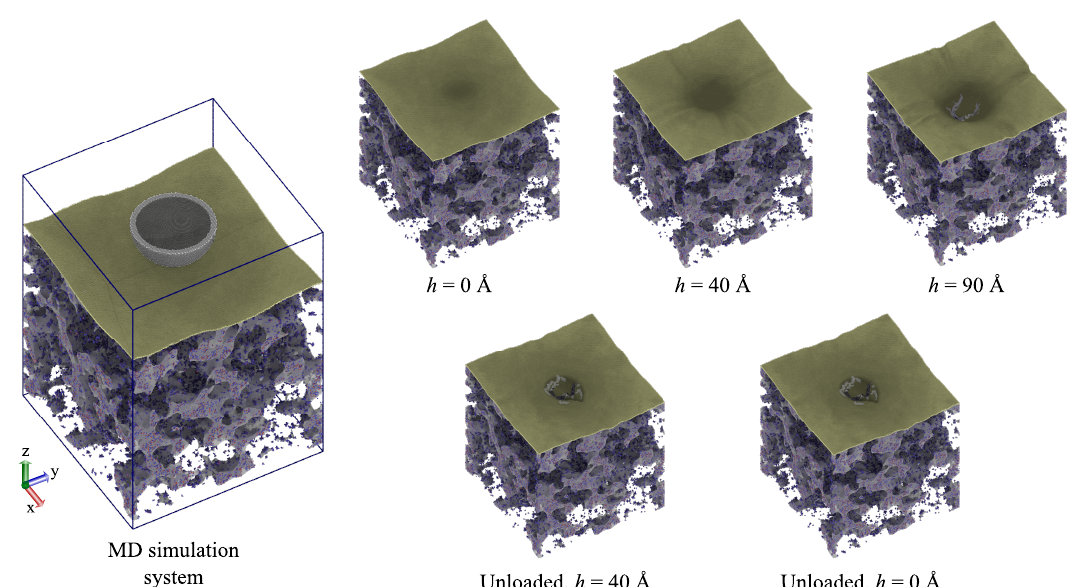
Figure 3. Nanoindentation on a 1G-SiO 2 system. The snapshots depict the deformation of the graphene sheet and silica aerogel during loading and